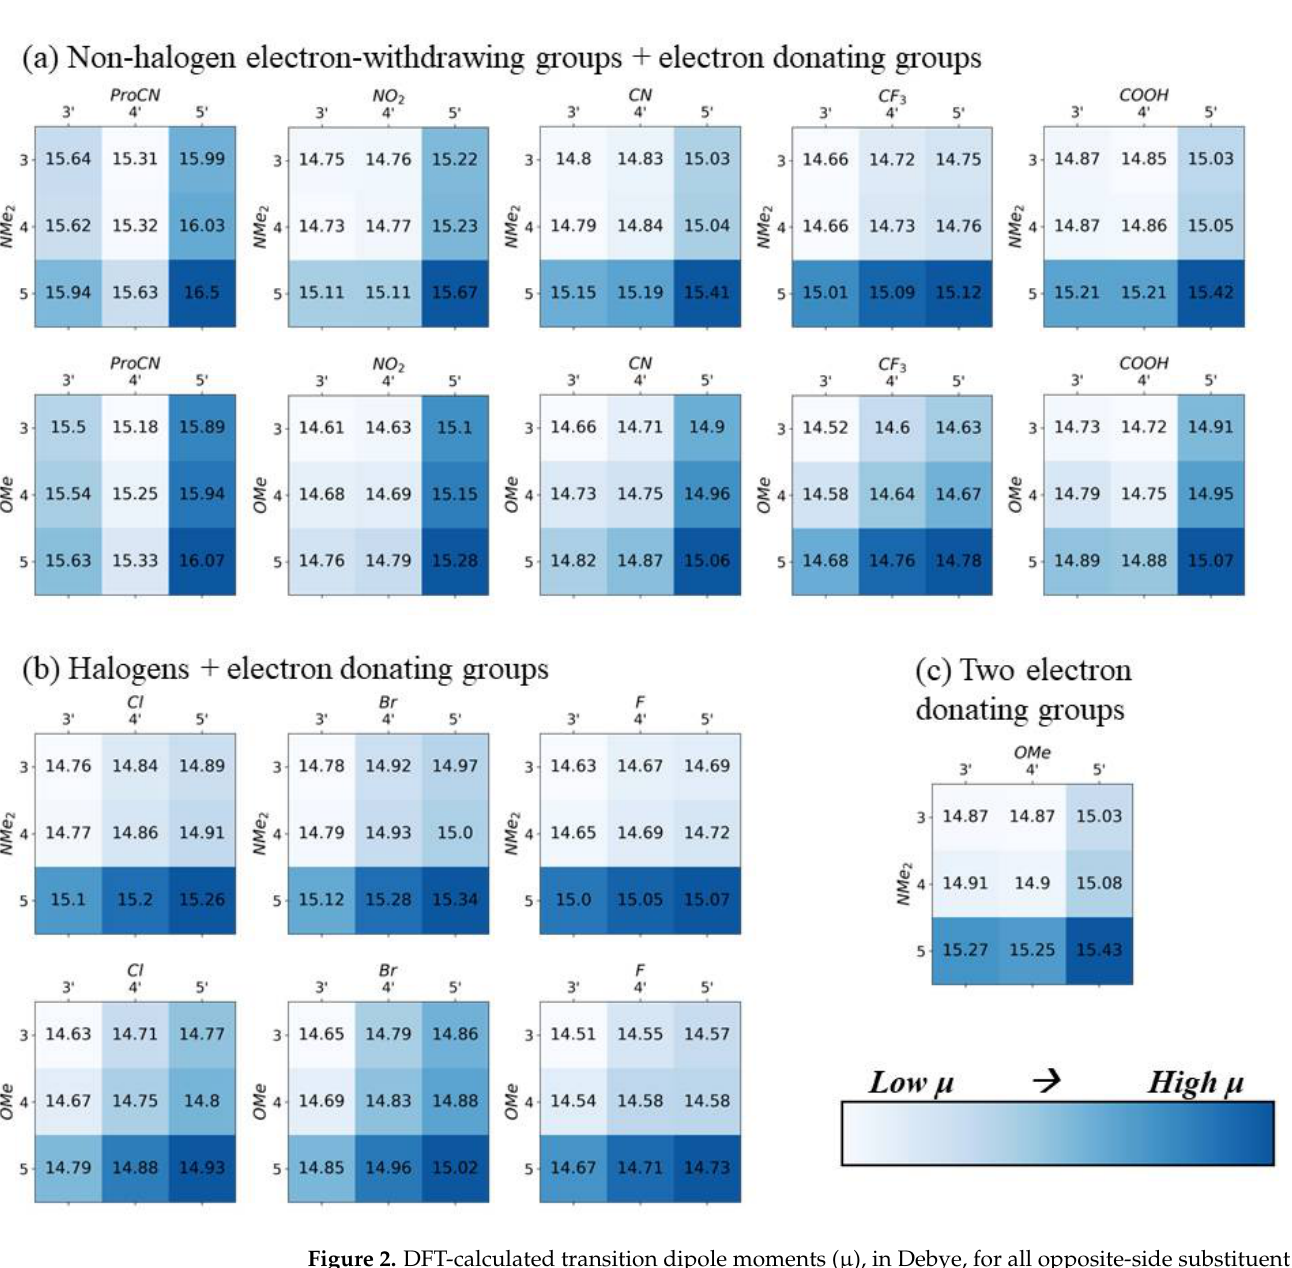
Figure 2. DFT-calculated transition dipole moments ( µ ), in Debye, for all opposite-side substituent pairs. Darker blue indicates a larger transition dipole moment. All calculations were performed with implicit solvation in water, using the integral equation formalism polarizable continuum model (IEFPCM) method (see more details in the methods section). Darker colors indicate higher values. The color range is only consistent for each substituent pair, and color-coding should not be used to compare values between pairs.